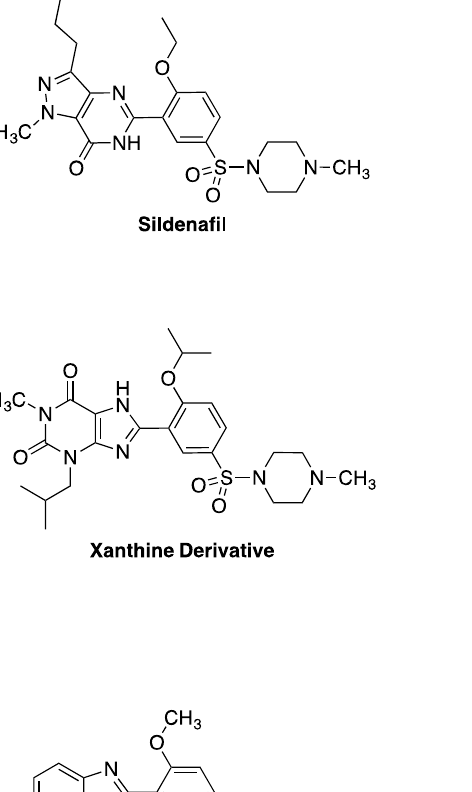
Figure 1. The chemical structures of sildenafil, vardenafil, xanthine derivative, pyrrolopyrimidinedione derivative and the target